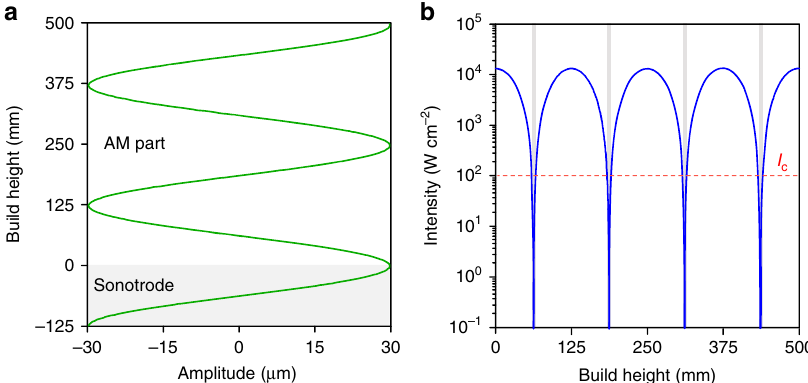
Fig. 7 High-intensity ultrasound conditions during AM of Ti-6Al-4V. a Change in amplitude by Eq. (2) versus the vertical axis of the acoustic system. b Change in intensity by Eq. (3) versus build height. The red dashed line in b corresponds to the intensity required to overcome the cavitation threshold in molten light metals ( I c ≥ 100 W cm − 2 (ref. 34 )). The gray regions in b denote when cavitation